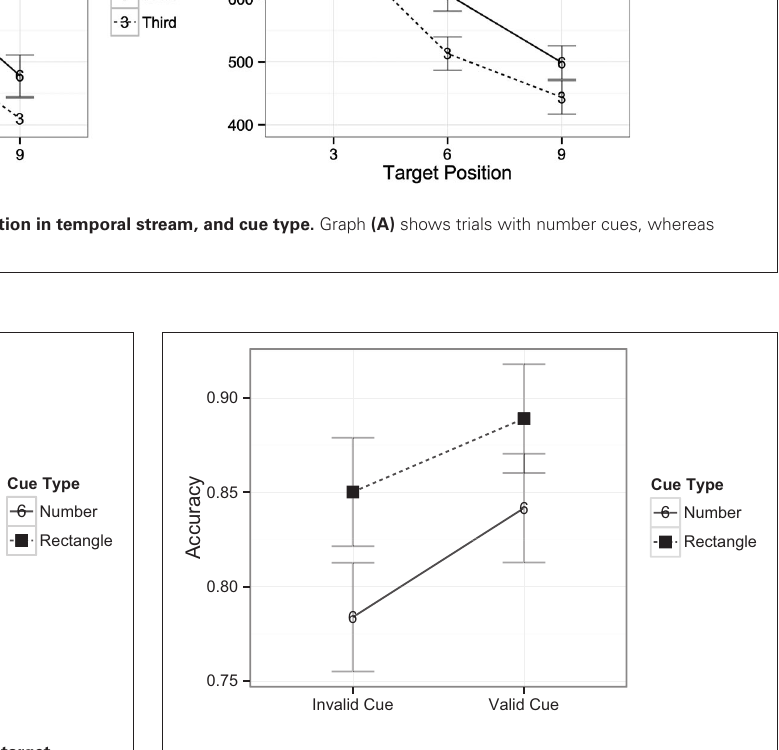
FIGURE 6 | Interaction of cuing effects within the spatial target detection condition.